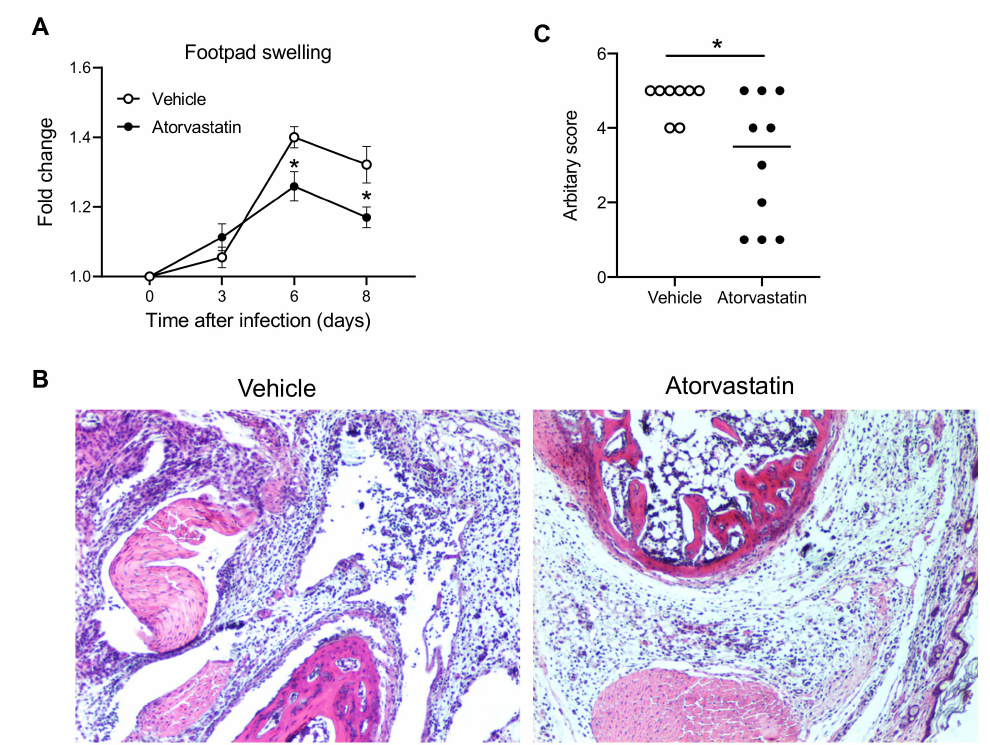
Figure 2. Atorvastain suppresses CHIKV arthritis. Mice were injected intraperitoneally with dimethyl sulfoxide (vehicle) or atorvastatin (25 mg / kg / day) from Day 3 through 8 post CHIKV infection (p.i.) on a daily basis. ( A ) Fold changes in the footpad dimensions of infected mice (Days 3, 6, and 8) in comparison to the uninfected mice (Day 0) ( n = 8 for vehicle and 10 for atorvastatin). Error bar: mean ± s.e.m. ( B ) Representative H&E micrographs (100 × ) and ( C ) arbitrary score of H&E on Day 8 p.i. The horizontal line in ( C ) is the median of the results. * p < 0.05, two-tailed Student’s t -test for ( A , C ). Each symbol represents one